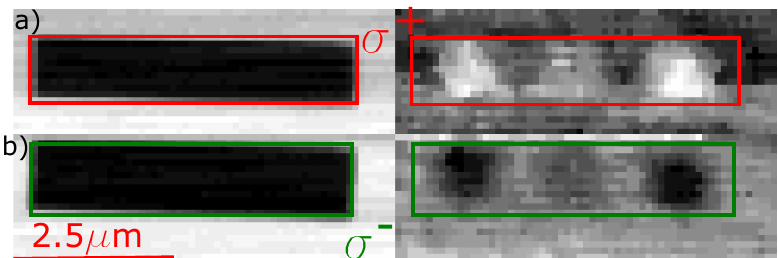
Figure 6. Comparison of the two circular polarizations for an inhomogeneous excitation of a T stripe. The left part shows the chemical contrast pictures for the different polarization measurements, respectively. For contrast maximization, the opposite phases of the same measurement are subtracted. The red and green boxes indicate the position of the Py stripe (extracted from the chemical contrast) for each of the two measurements to better visualize the